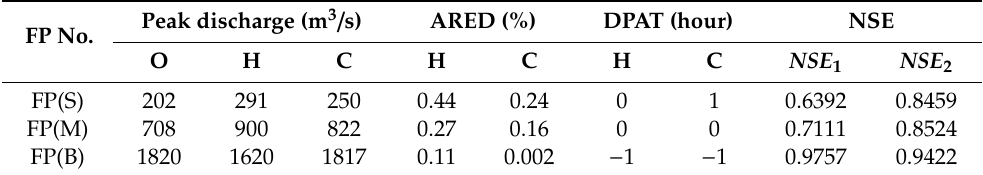
Table 4. The statistical analysis of the measured and simulated discharge